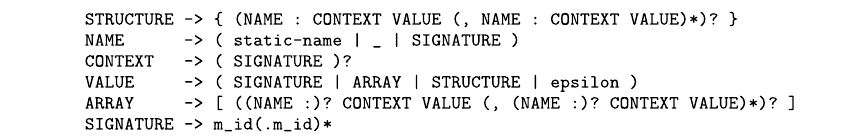
Fig. 5 Grammar of the JSON-like representation of access